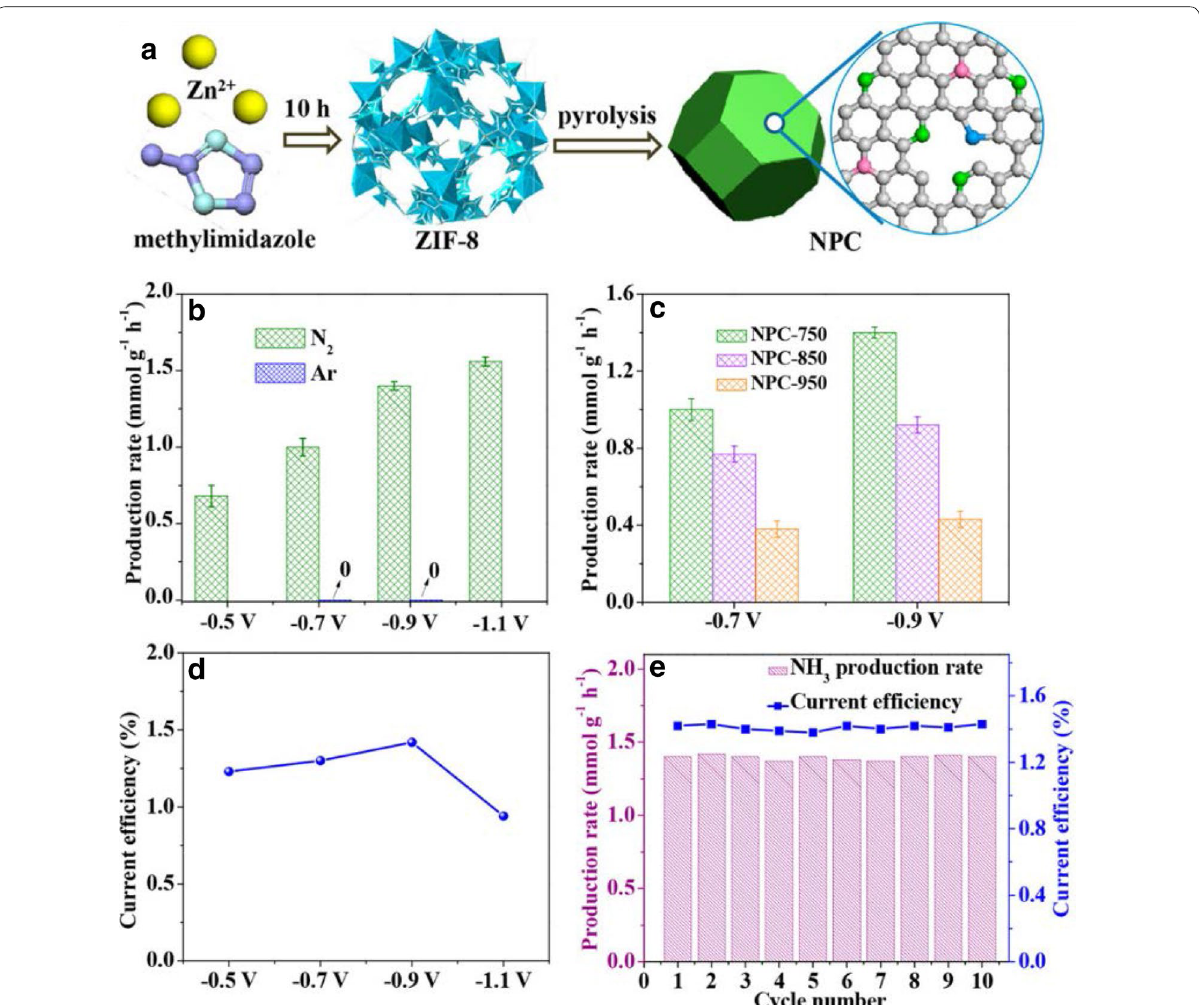
Fig. 4 a Graphical illustration of the NPC preparation method. b NH 3 production rates for NPC‑750, NPC‑850, and NPC‑950. c NH 3 production rates at 0.74 V and 0.9 V for NPC‑750,850 and 950 d Current efficiency of NPC‑750. e Recyclability test for NPC‑750 for 10 consecutive cycles at − − (Reproduced with permission [32] Copyright 2017, American Chemical Society